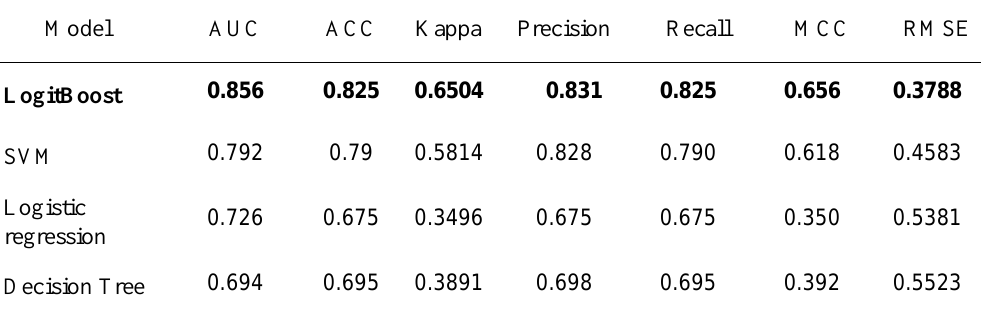
Table 2. Classification performance for LBP